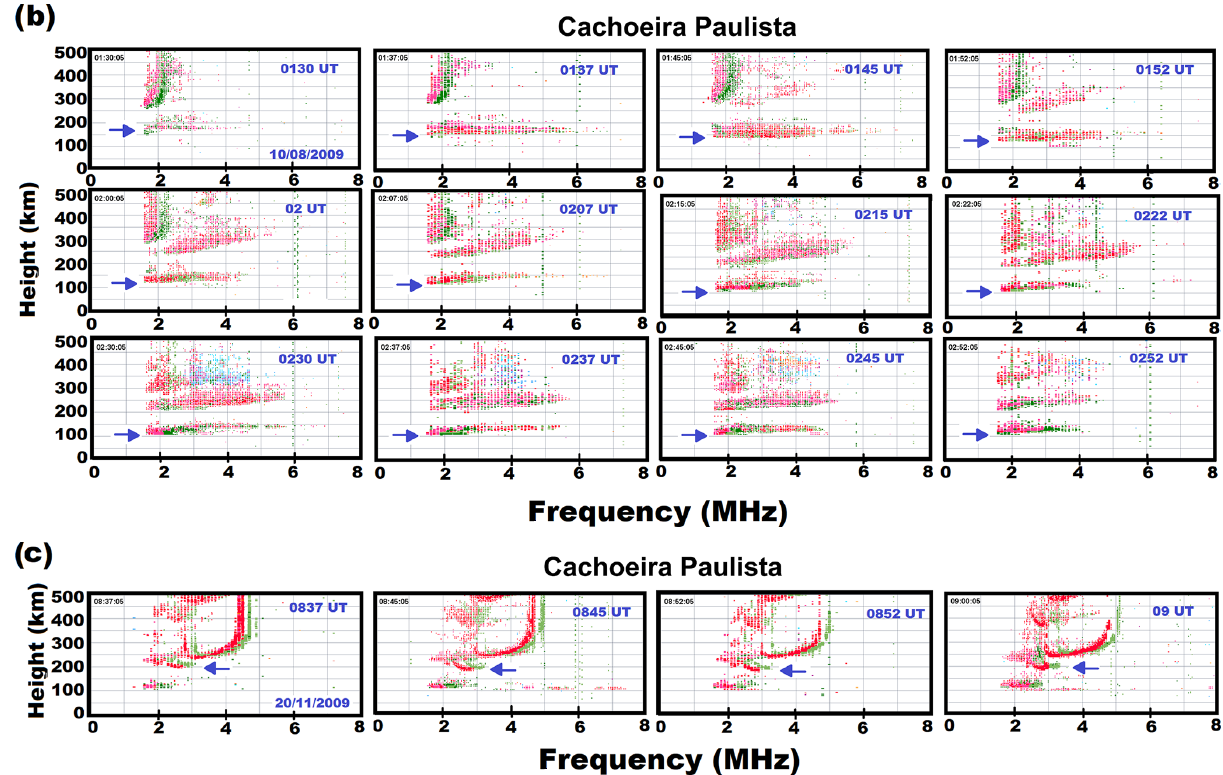
Figure 7. (a) Ionograms over São Luís showing some examples of nocturnal intermediate layers on different days. (b) Same as (a) , but for Cachoeira Paulista during 10 August. (c) Nocturnal intermediate layer over CP starting with a retardation in height similar to that of the h -type sporadic